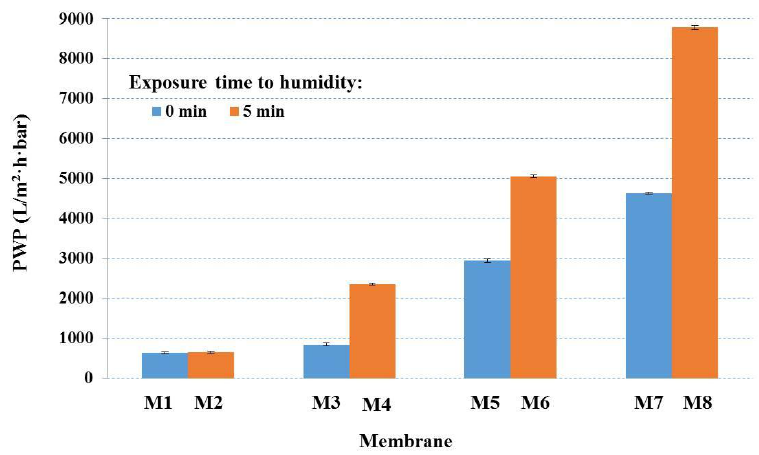
Figure 4. Pure water permeability (PWP) of the prepared PES and PES-kaolin membranes.